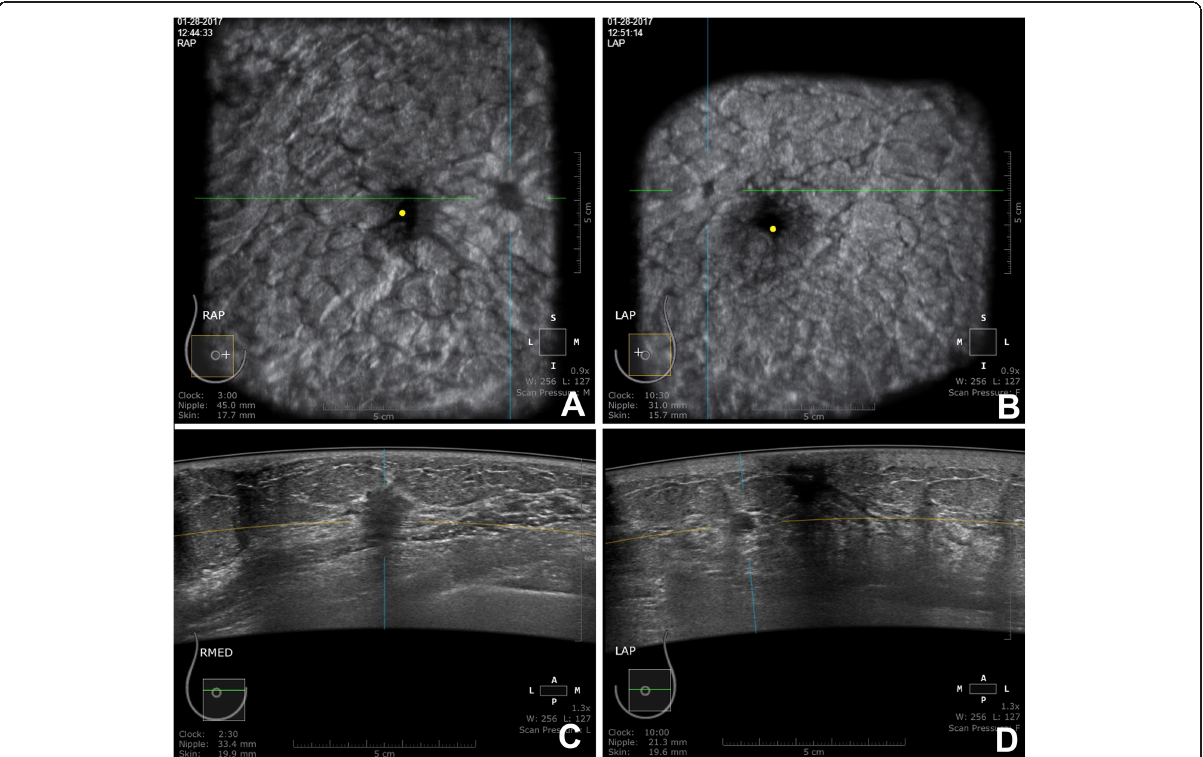
Fig. 2 Female patient 24 years old with histopathological diagnosis of an invasive ductal carcinoma type II. a Coronal reformatted ABUS images of the right breast showing a well-defined hypoechoic lesion in its upper inner quadrant. b Coronal reformatted ABUS images of the left breast showing a smaller well defined hypoechoic lesion in its upper inner quadrant. c Axial ABUS image of the lesion in the right breast showing a well-defined hypoechoiec lesion showing irregularity of its border with posterior acoustic shadowing the lesion was graded as a BI-RADS IV lesion. d Axial ABUS image of the lesion in the left breast showing a small rounded hypoechoiec lesion with well-defined border and regular outlines. This lesion was missed on HHUS